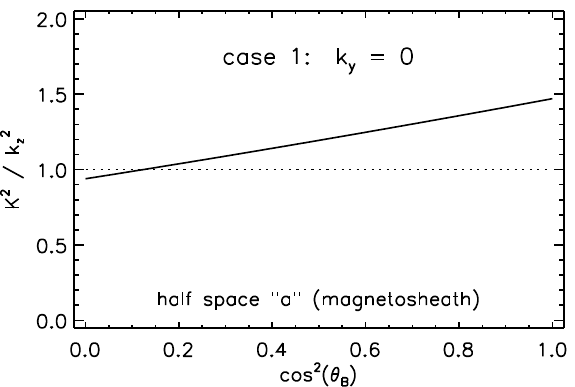
Fig. 2. Ratios K 2 /k 2 z = K 2 /k 2 t of half space “a” (magnetosheath) for different values of cos 2 θ B and typical plasma conditions given in the text. Case 1 ( k y = 0) has been considered. For low ratios K 2 /k 2 z (cid:28) 1 the assumption of incompressibility would be